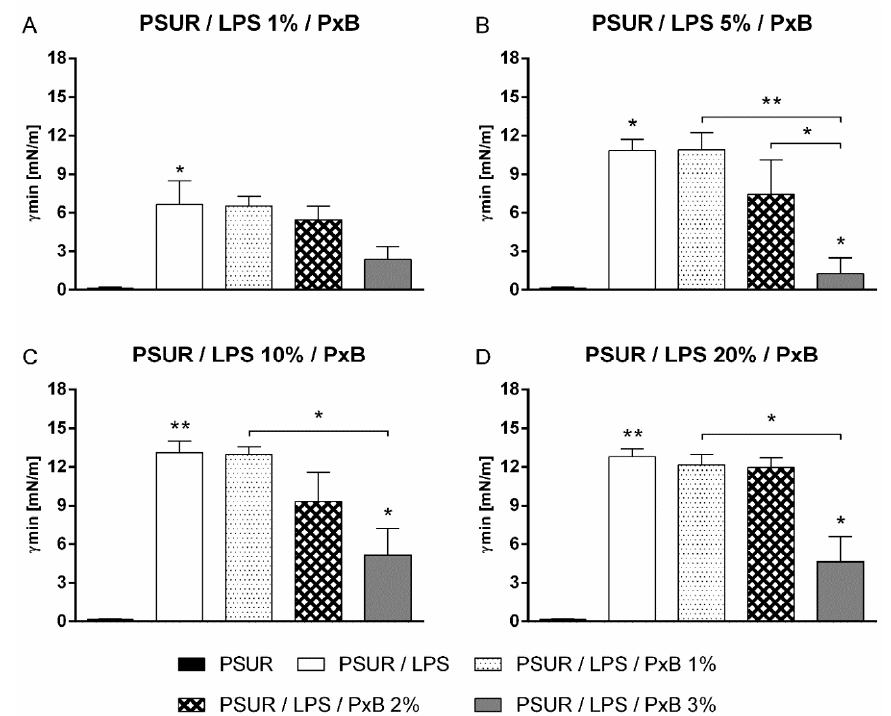
Figure 2. Minimum surface tension ( γ min ) of modified porcine surfactant (PSUR) at phospholipid concentration of 1.75 mg/mL with lipopolysaccharide (LPS) at 1% ( w / w ) and polymyxin B (PxB) at 1%, 2%, and 3% ( A ); LPS at 5% and PxB at 1%, 2%, and 3% ( B ); LPS at 10% and PxB at 1%, 2%, and 3% ( C ); and LPS at 20% and PxB at 1%, 2%, and 3% ( D ) after 5 min of pulsation. Values are given as means ± SEM. PSUR vs PSUR/LPS; PSUR/LPS vs PSUR/LPS/PxB: * p < 0.05 and ** p < 0.01.